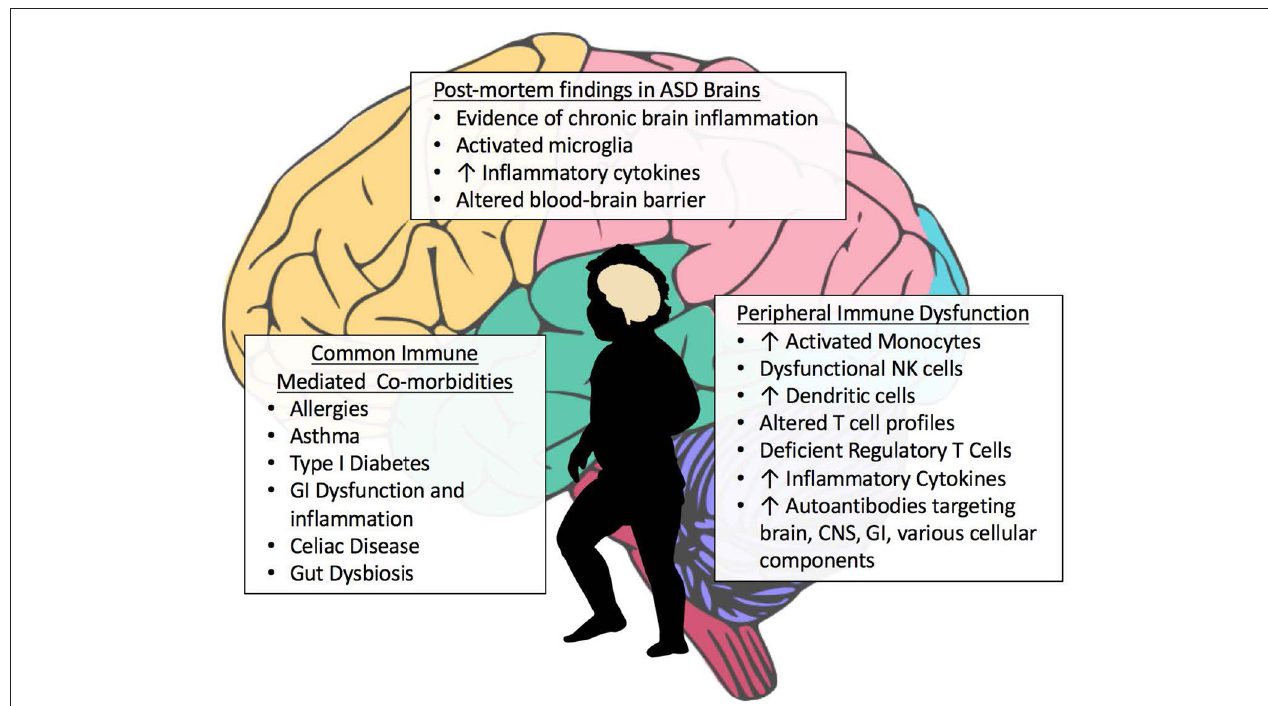
FIGURE 2 | Aberrant Immune Findings in Individuals with ASD. Evidence of immune dysfunction in ASD has grown substantially in recent years. Individuals with ASD commonly have immune-mediated comorbidities such as allergies and gastrointestinal (GI) dysfunction that may be contributing to the aberrant behaviors seen in ASD. Although research in this area is occasionally contradictory, the vast majority of immune studies in individuals with ASD have shown immune dysfunction and dysregulation. Several studies have found elevations in inflammatory cells and cytokines, both peripheral as well as within post-mortem brain tissue. A variety of autoantibodies targeting various tissues and cellular components throughout the body have been identified in subsets of subjects with ASD. Individuals with ASD also have fewer regulatory T